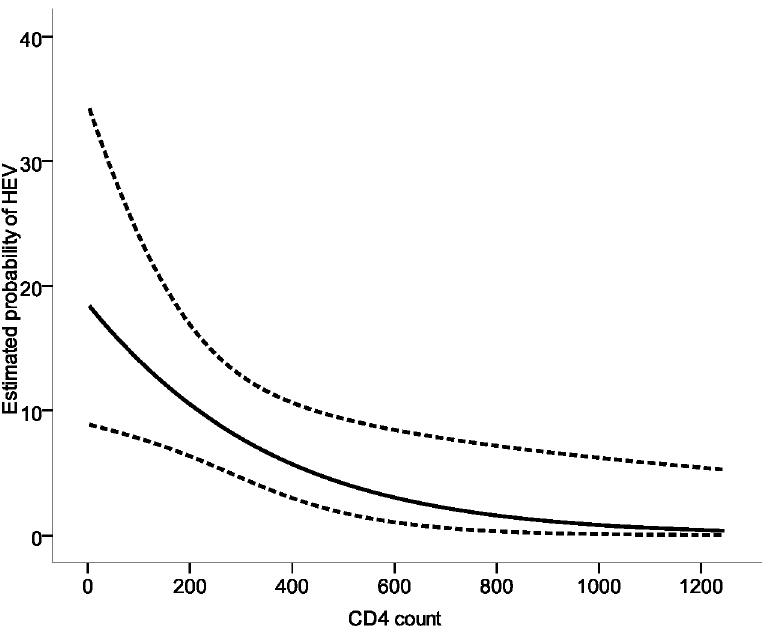
Fig 1. Estimated probability of HEV by CD4 count (full line) with 95% confidence interval (dotted